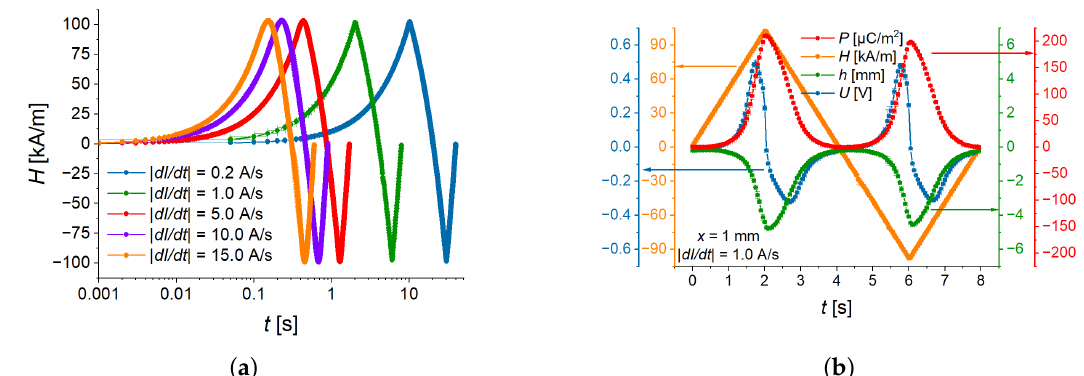
Figure 3. ( a ) One cycle of magnetic field oscillations in the logarithmic time scale for the case H max ≈ 103 kA/m. ( b ) Typical responses of polarization (red, P ), deflection (green, h ) and voltage (blue, U ) to triangular waveform with a slew rate of 53 kA/sm (orange, H